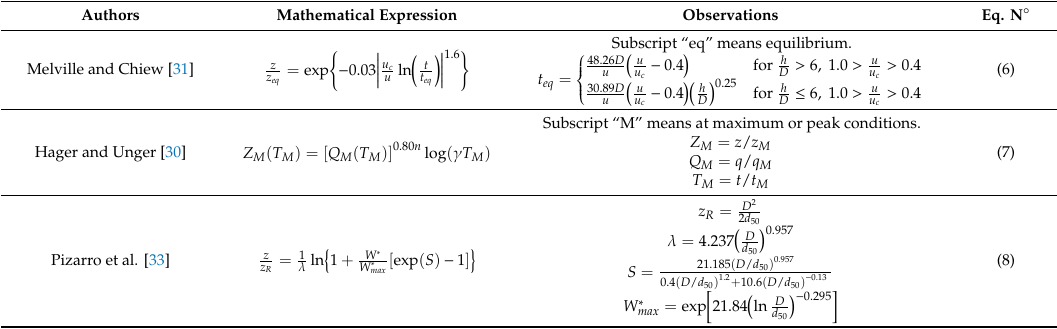
Table 1. Time-dependent scour prediction